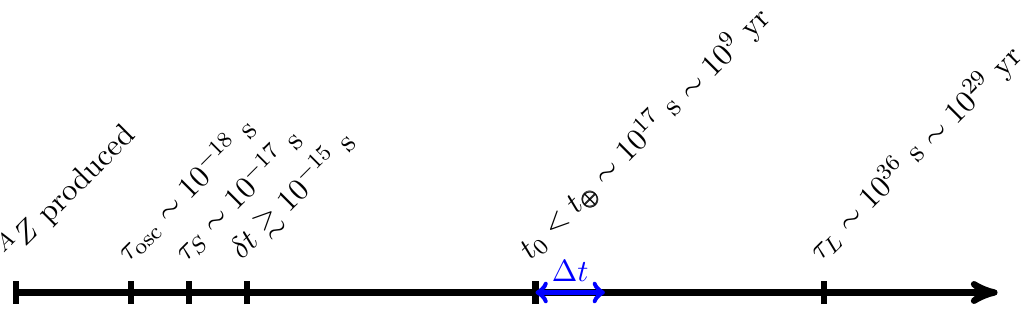
Figure 4 . Timeline of the mixed atomic system. The (cid:28) osc ; (cid:28) S and (cid:28) L values are for 152 Gd ! 152 Sm, whereas (cid:14)t is a typical time resolution, t 0 is the age of the sample ore, t (cid:8)(cid:8)(cid:8) is the age of the Earth and (cid:1) t is the observation time in an actual